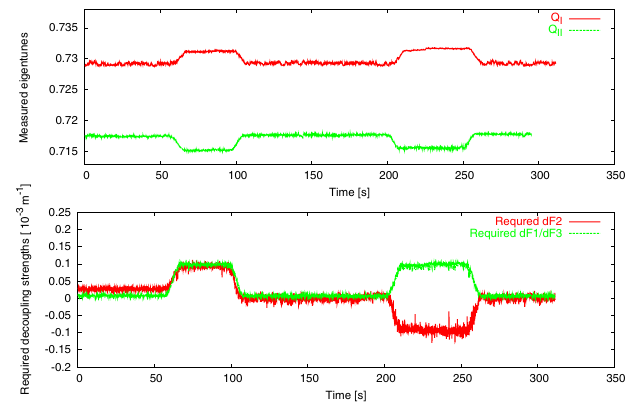
FIG. 4. (Color) The measured eigentunes and the required cou- pling correction